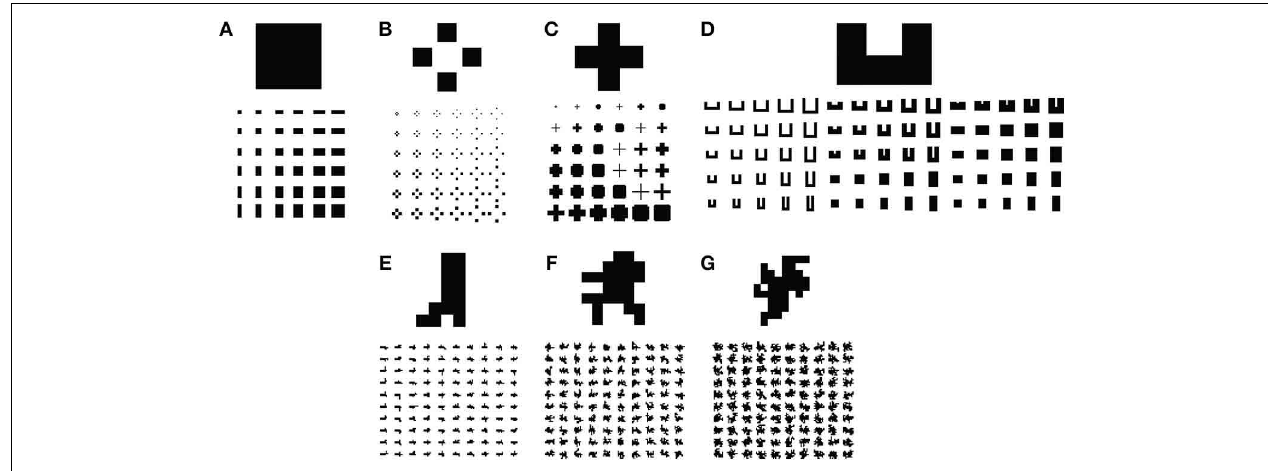
FIGURE 6 | Visual displays used in simulations to test the model. Five hundred of each type of visual display depicted in (E,F) were parametrically generated. Only 100 are shown. (A) Rectangles. (B)